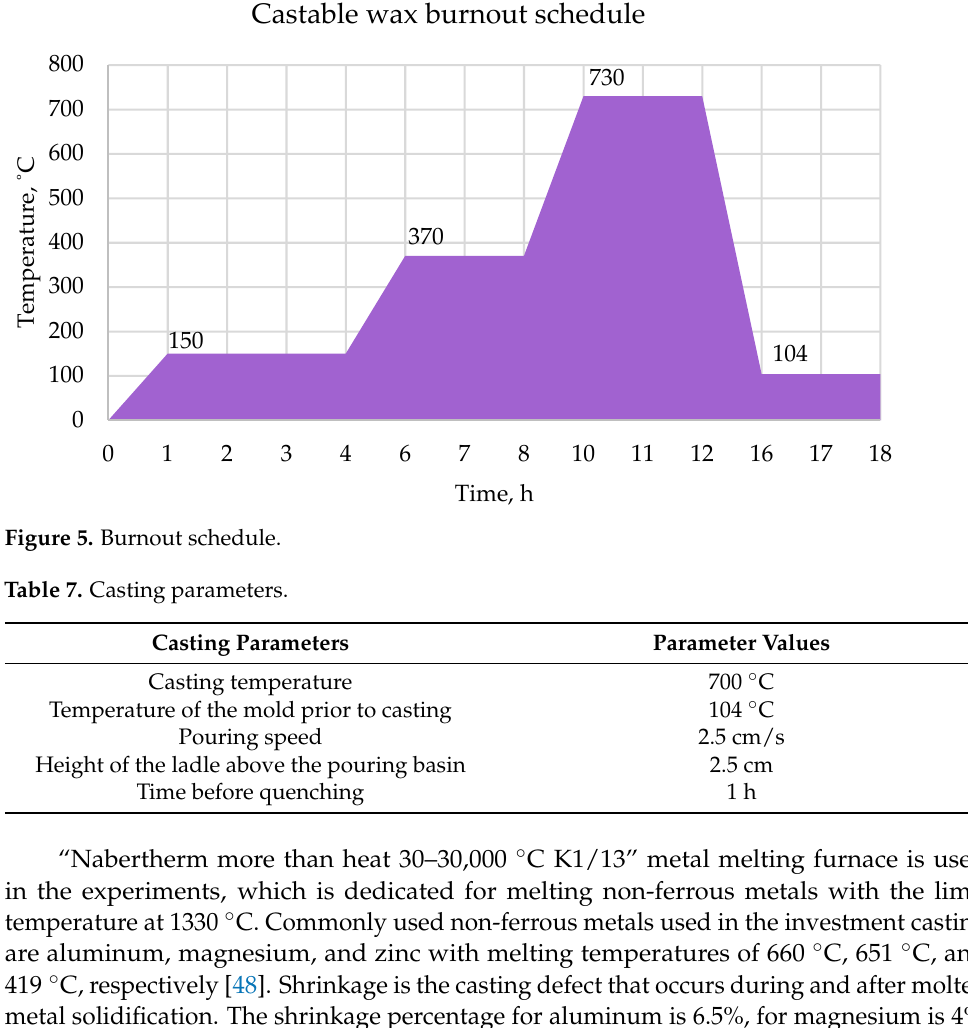
Table 7. Casting parameters.